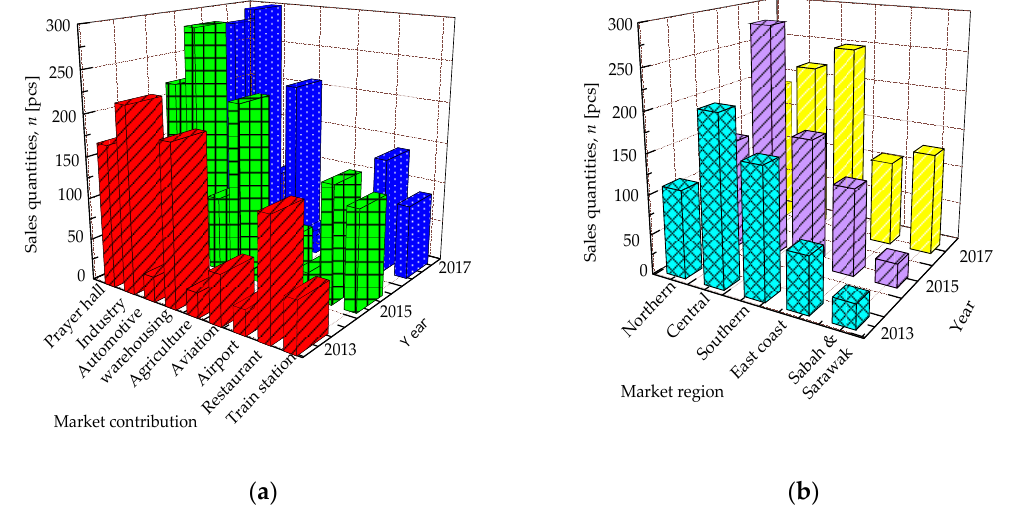
Figure 11. Local market share ( a ) Market contribution of monstrous fan ( b ) Sales region in Malaysia.